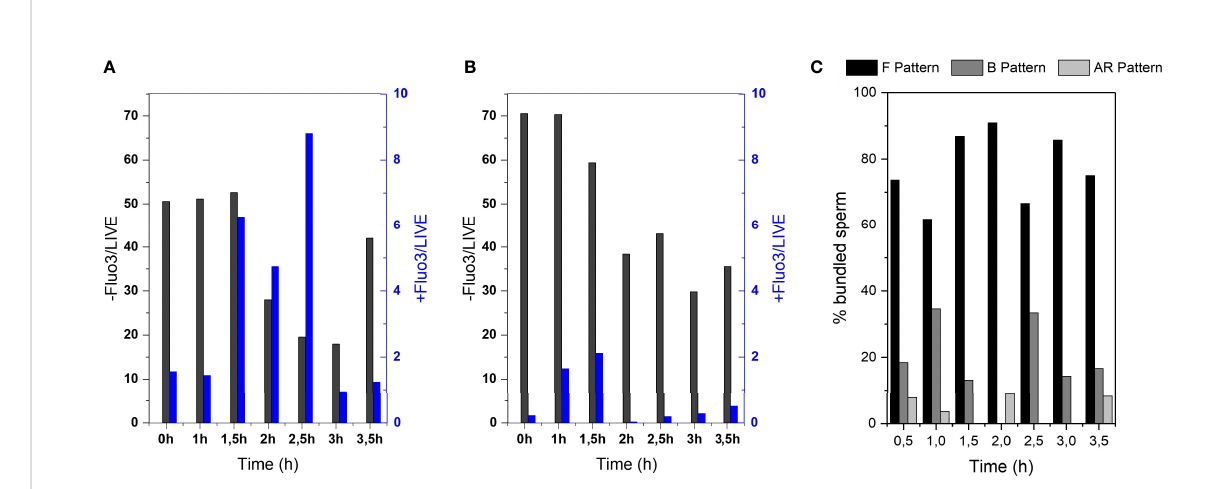
FIGURE 5 Investigation of amount of capacitated sperm over post-thawing incubation time. Flow cytometry results of Fluo-3 stained bull sperm at different post-thaw incubation times after swim-up in (A) DMEM (B) DMEM + BSA. (C) CTC assay results of sperm bundles showing the % of bundled sperm displaying the F pattern (non-capacitated), B pattern (capacitated, acrosome intact) or AR pattern (acrosome reacted).